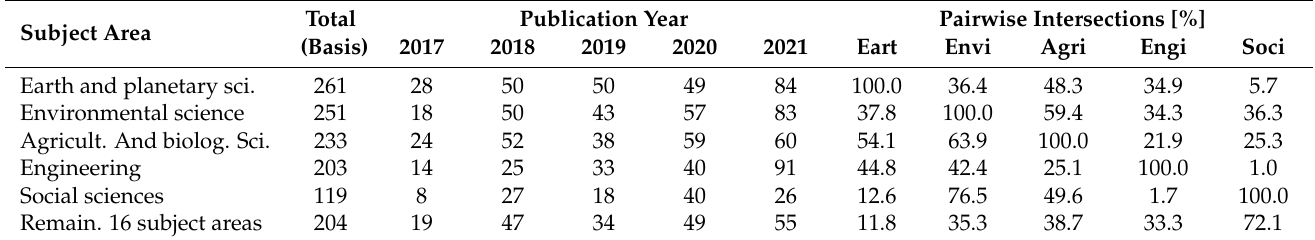
Table 3. Publication numbers and pairwise intersection for the top five subject areas